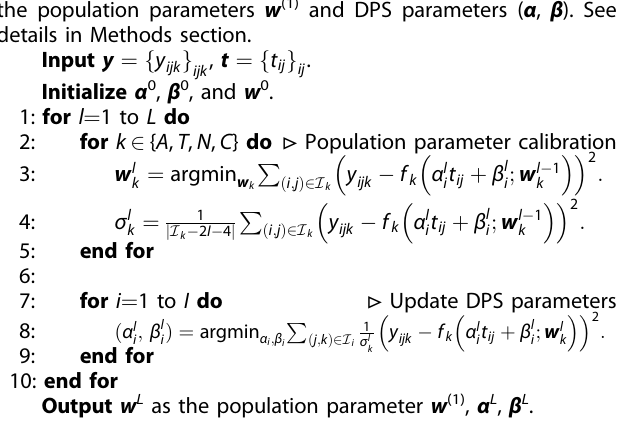
Algorithm 1 . Population model calibration algorithm to compute the population parameters w (1) and DPS parameters ( α , β ). See